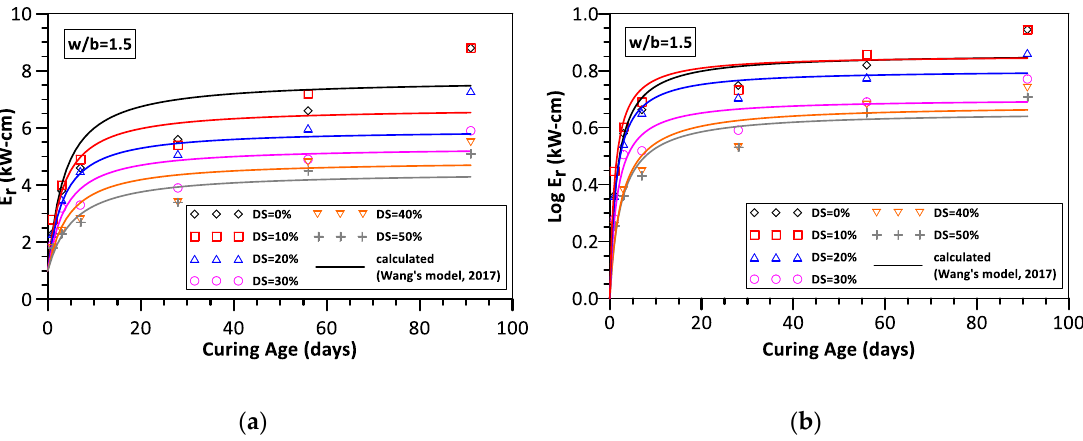
Figure 17. ( a ) Comparison of the surface resistivity between the predicted analysis and test results (under normal scale coordinates). ( b ) Comparison of the surface resistivity between the predicted analysis and test results (after transfer to the semi-logarithm scale coordinates).